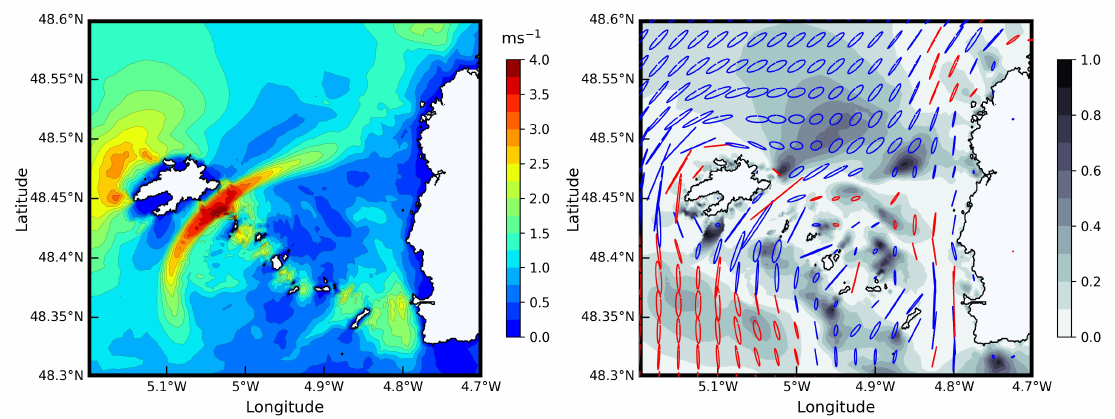
Figure 4. ( left ) Peak magnitude of depth-averaged tidal currents resulting from M 2 , S 2 and M 4 harmonic components. ( right ) M 2 tidal current ellipses with ellipticity (defined as the ratio between magnitudes of the semiminor and semimajor axes of ellipses) shown as colorscale. Given the prevalent nature of M 2 over the northwest European shelf seas, low ellipticity accounts therefore for nearly rectilinear tidal currents whereas high ellipticity exhibits the circular nature of tidal currents. Blue and red ellipses indicate clockwise and anticlockwise rotations, respectively (adapted from